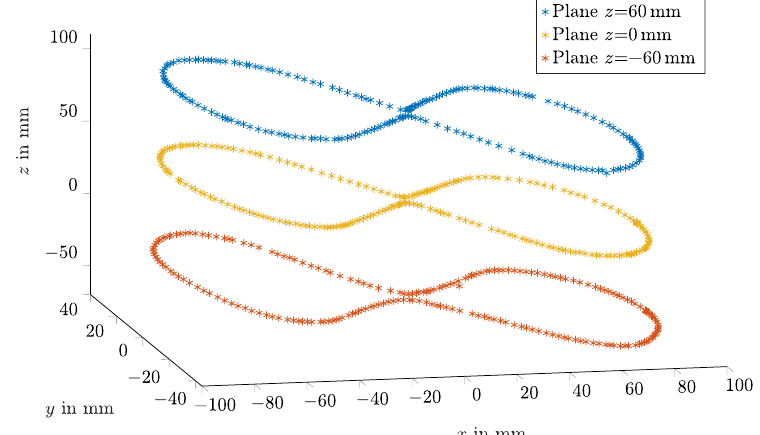
10 mm magnet while its magnetisation ×